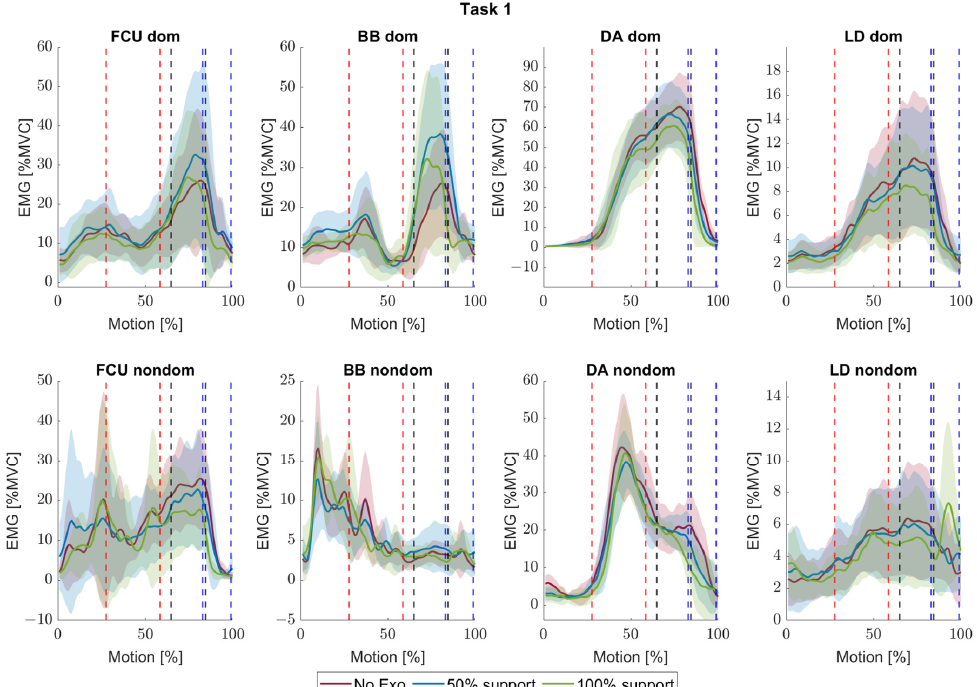
Figure 9. The participants’ average EMG curves during the complete motion sequence, in task T1, under three test conditions. The shadows represent the standard deviations. Three motion phases are marked from left to right on the graphic: (1) arm lifting was between two red dashed lines; (2) screw was between two black dashed lines; (3) arm lowering was between two blue dashed lines.